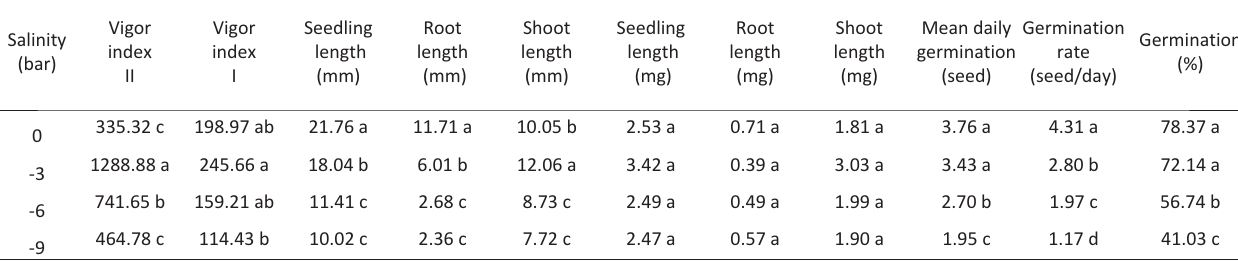
Means, in each column, followed by same letter are not significantly different at the 5 % probability level­ using Tukey Test. n=nano,